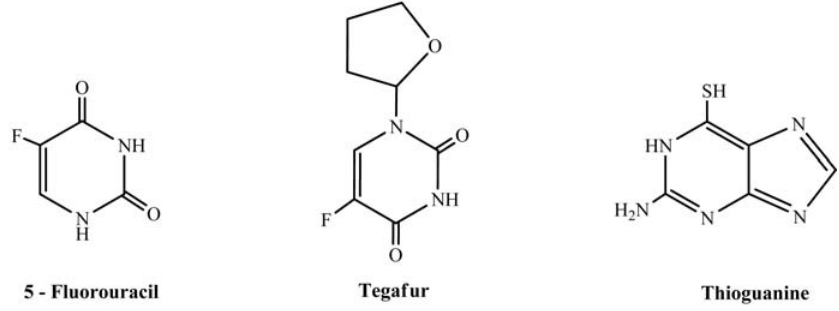
Figure 1 . Pyrimidine derivatives as anticancer